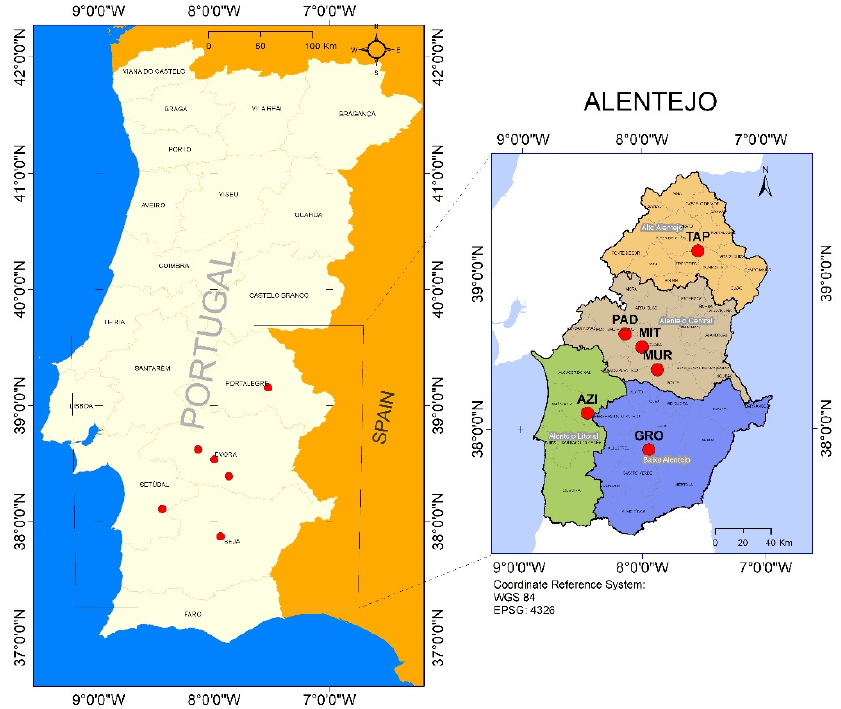
Figure 2. Location of the six dryland permanent pastures in the southern Alentejo region of Portugal.